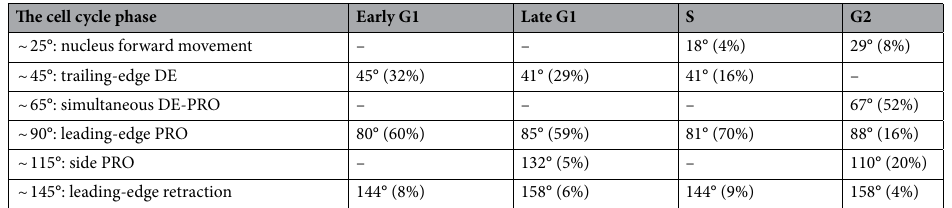
Table 1. The proportions of subcellular activities contributed to the cell migration patterns of cells in different cell cycle phases. The table listing the subcellular activities with signature polar angles and their percentiles in each stage of the cell cycle phases, determined by the CN correlation analysis. DE and PRO denote detachment and protrusion,